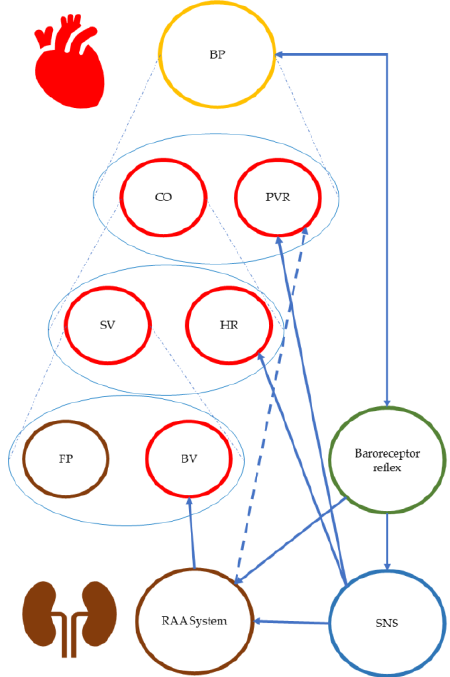
Figure 1. Schematic representation of the “mechanisms” regulating the blood pressure in the human body. BP: blood pressure, CO: cardiac output, PVR: peripheral vascular resistance, SV: stroke volume, HR: heart rate, BV: blood volume, FP: filling pressure (kidney), BV: blood volume, SNS: sympathetic nervous system, RAA System: renin-angiotensin-aldosterone system. This scheme has been adapted from a pharmacology textbook namely, Brenner and Stevens’ Pharmacology 5 th edition p. 105) [4,5].